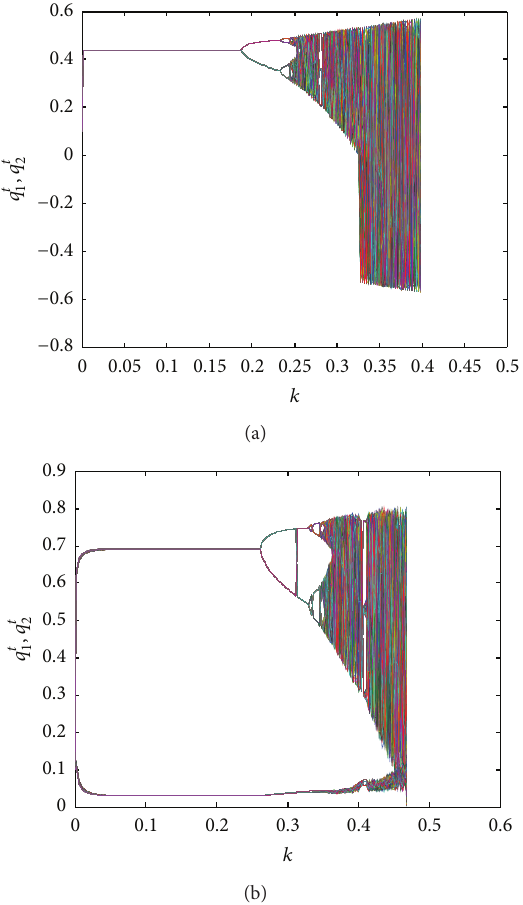
Figure 2: Bifurcation and chaos of the map (6) at the parameters: (a) 𝑎 = 3 , 𝑏 = 1.5 , 𝑐 = 0.3 , 𝜀 1 = 2 , 𝜀 2 = 6 , and 𝛾 = 0.3192 ; (b) 𝑎 = 3 , = 2 , 𝜀 = 6 , and 𝛾 = .3714 𝑏 = 1.5 , 𝑐 = 0.3 , 𝜀 1 2